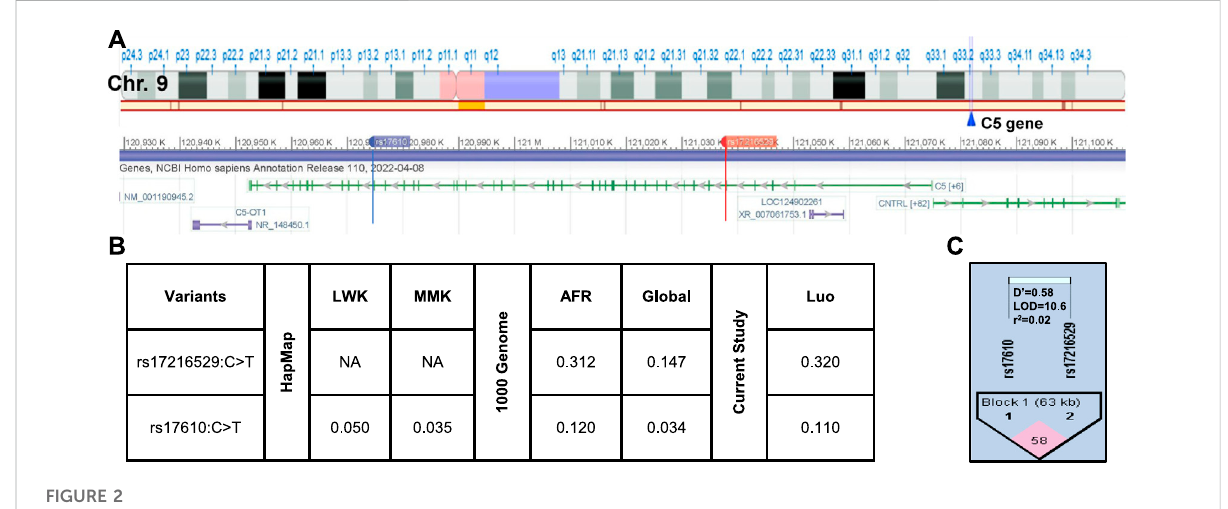
FIGURE 2 C5 chromosome location and linkage disequilibrium (LD) plot of the selected missense mutations (A). Location of C5 on Chromosome 9q33.2. C5consistsof1,682 aminoacidsandconsistsof43exons.Chromosomeposition(buildGRCh38.p14)fortheinvestigatedSNPsrs17216529:C > Tand rs17610:C > T.The alignment and genestructure for C5wasretrieved fromdbSNP database (B). C5 genotype minor allele frequencies (MAF) fromthe HapMap database for Kenyan populations [Luhya (LWK), Maasai (MKK) and calculated by MIDAS for the Luo (current study). MAFs from the 1,000 Genome project shows the African (AFR) and global allele frequencies. MAFs for the current Luo (Kenyan) population are also presented (C). Linkage disequilibrium plot for rs17216529:C > T and rs17610:C > T SNPs (D ’ = 0.581, LOD = 10.63, R 2 = 0.02). The two SNPs are in linkage equilibrium, that is, they are inherited